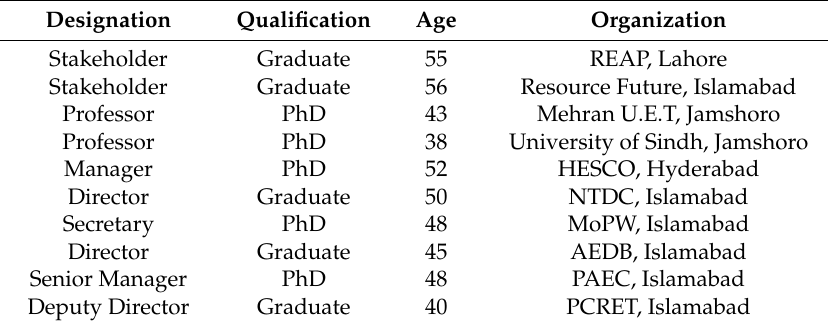
Table A1. Demographic information of